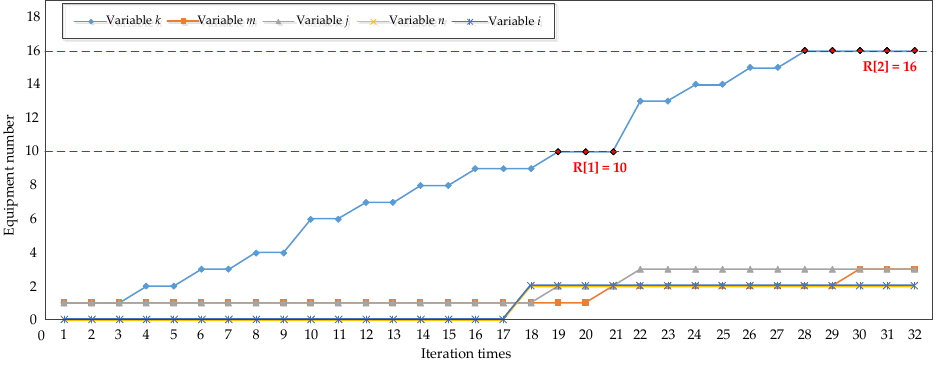
Figure 10. Iterative process of test case 3. Table 7. The operation steps of test case 3.